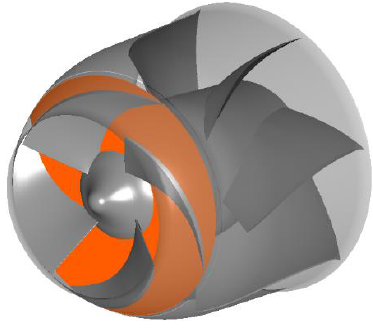
Figure 6. Section position of impeller outlet.